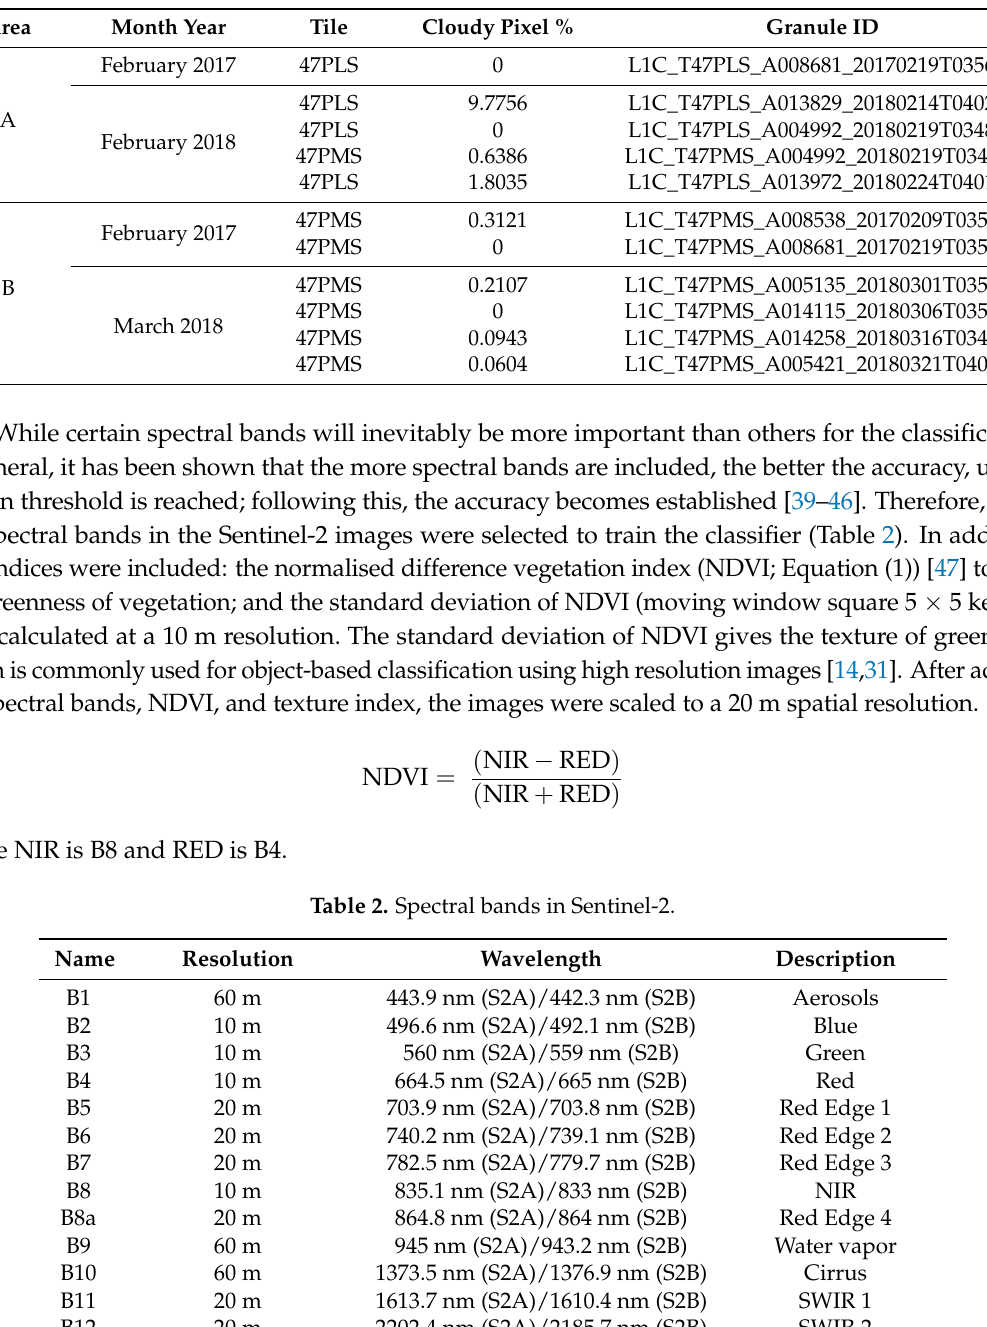
Table 1. Sentinel-2 images used for classification.